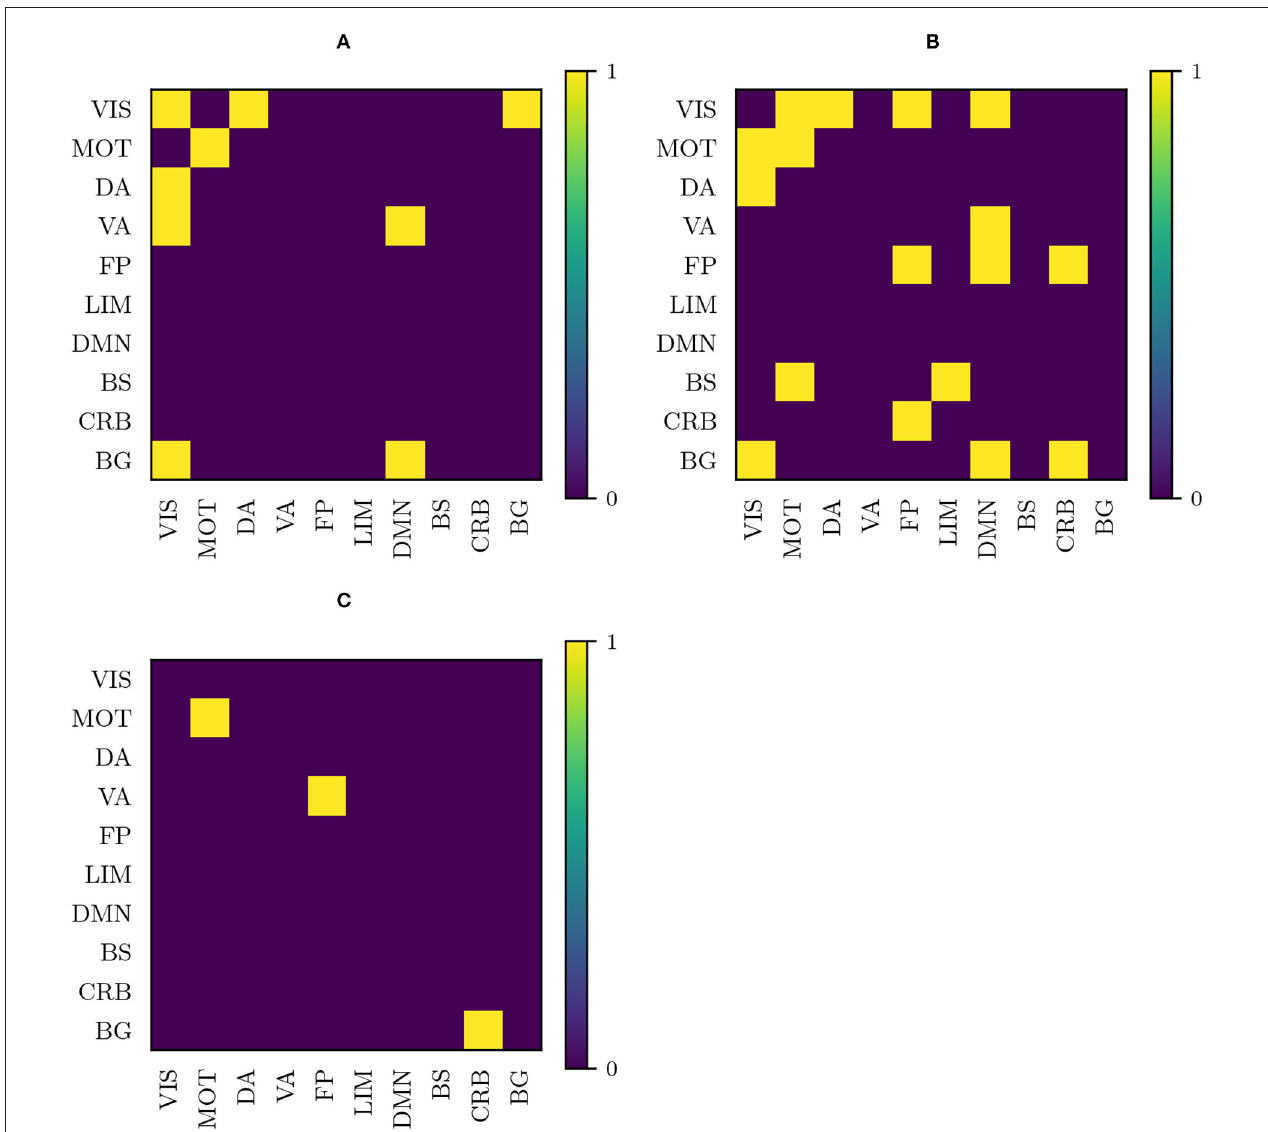
FIGURE 8 | Binarized entry-wise absolute differences greater than 15 % between plots in Figure 6 for (A) original (non-harmonized) matrices and matrices harmonized under Rigid Log-Euclidean Translation (RLET) to the global mean 6 ; (B) RLET to 6 and RLET to the identity matrix I harmonization approaches; (C) matrix whitening and RLET to I harmonized matrices. VIS, visual network; MOT, sensorimotor network; DA, dorsal attention network; VA, ventral attention network; FP, frontoparietal network; LIM, limbic network; DMN, default mode network; BS, brain stem; CRB, cerebellum; BG, basal